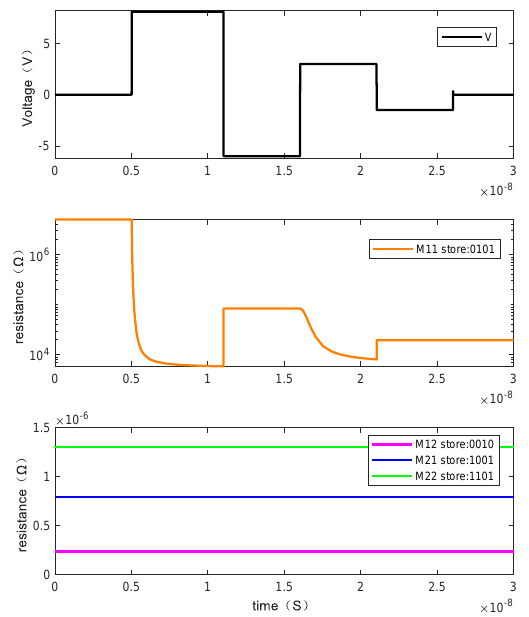
Figure 22. A structure of four adjacent memory cells.